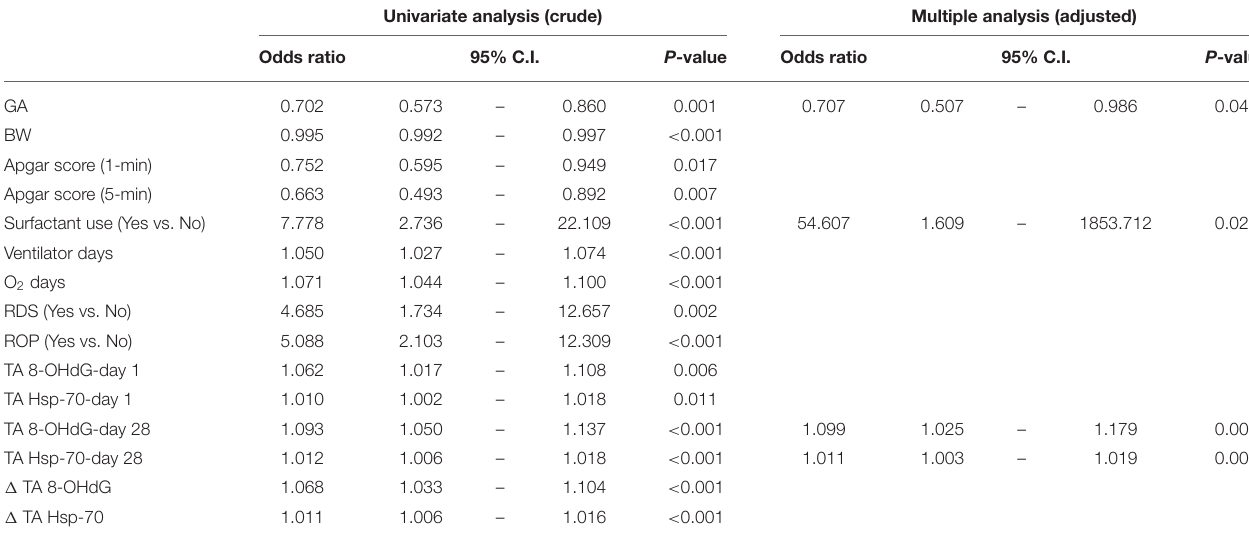
TABLE 2 | Regression analysis for the TA Hsp-70 and 8-OHdG levels in patients with bronchopulmonary dysplasia. Univariate analysis (crude) Multiple analysis (adjusted)